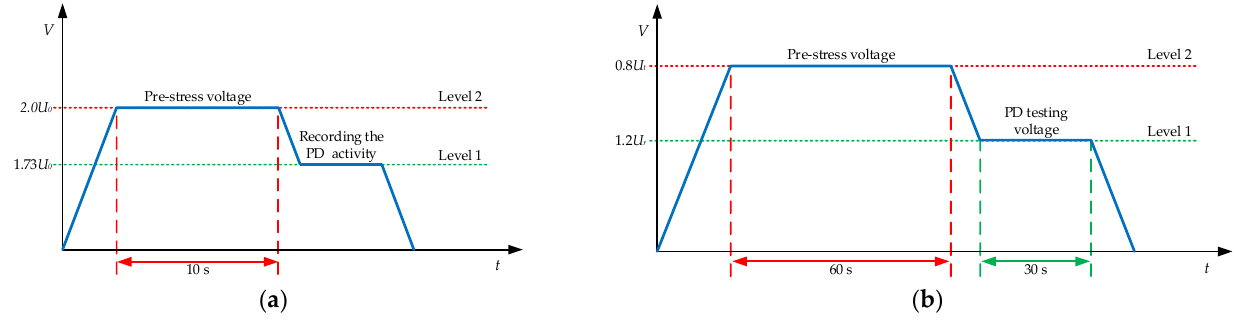
Figure 2. Application of voltage for the PD test: procedure ( a ) for the power cables, and ( b ) for the voltage transformers.